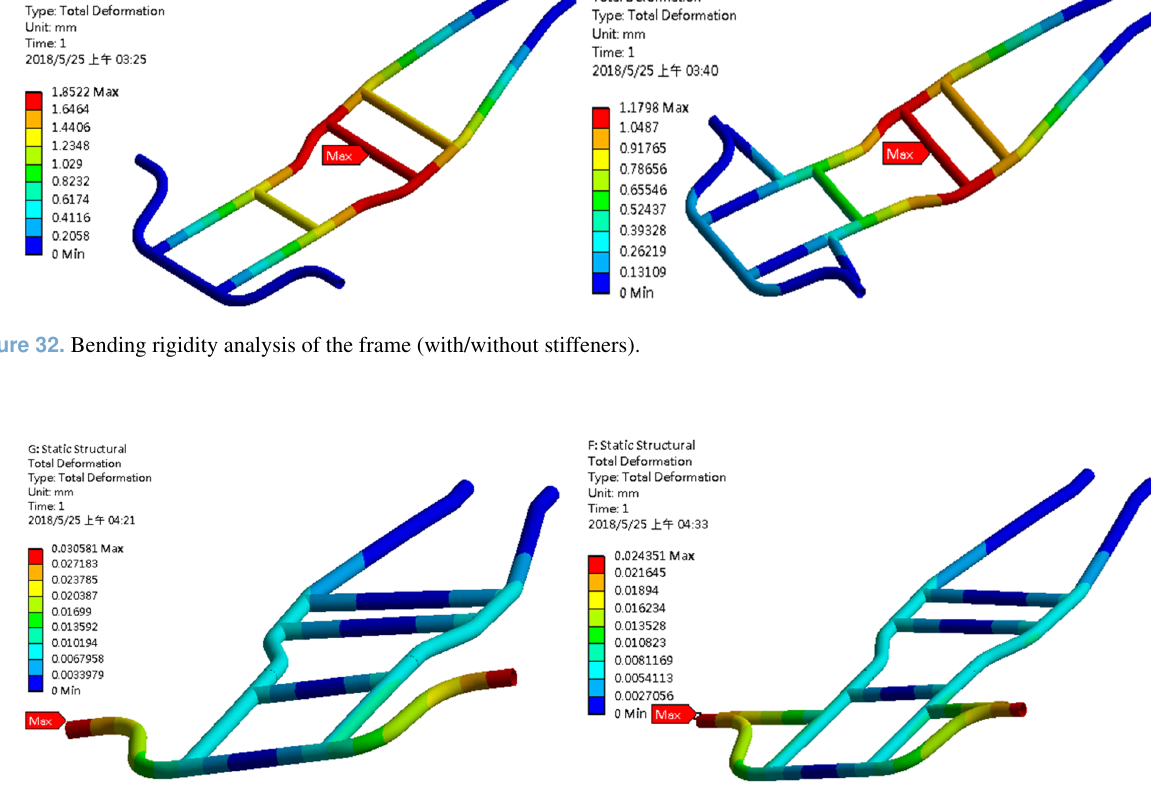
Figure 33. Torsional rigidity of the frame (with/without stiffeners).